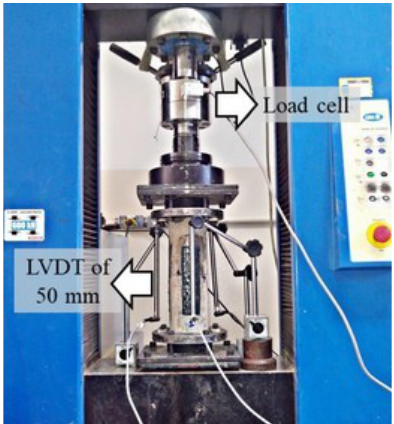
Figure 4. Apparatus with internal diameter of 100 mm for conducting direct tensile